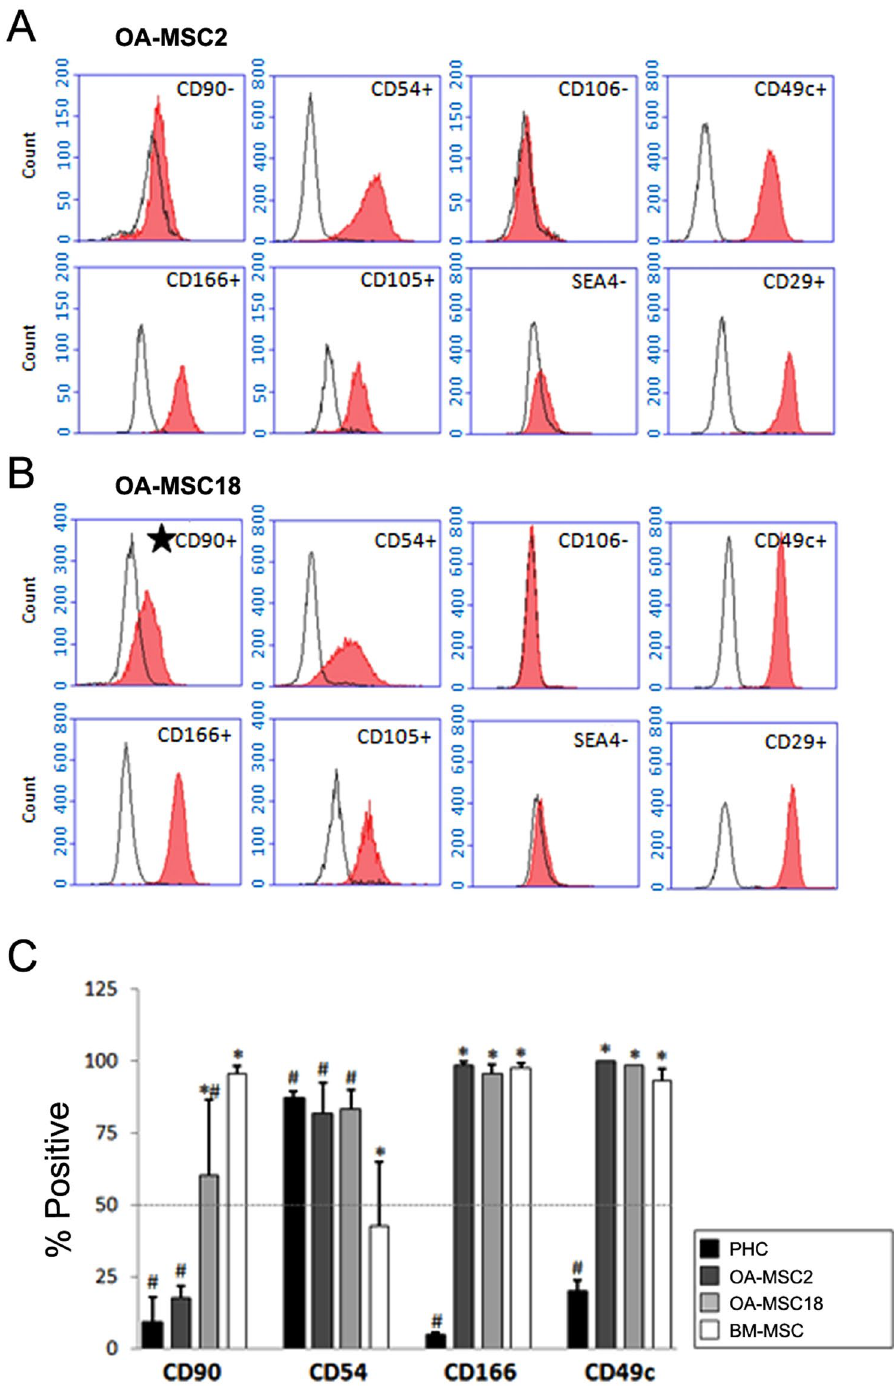
Figure 4. Cell surface marker analysis of clonal OA cartilage-derived MSCs. (A) Representative flow cytometry analysis of OA-MSC2 and (B) OA-MSC18. Empty peaks indicate the results obtained from cells stained with isotype control antibodies and filled peaks indicate the results of cells stained with the indicated specific target antibodies. (C) Histogram of compiled results of flow cytometry experiments using bone marrow derived mesenchymal stem cells (BM-MSCs), articular chondrocytes (PHCs), OA-MSC2 and OA-MSC18. n ≥ 3. # p ≤ 0.05, relative to BM-MSCs. * p ≤ 0.05, relative to PHCs. Quantitative data are represented as mean ±